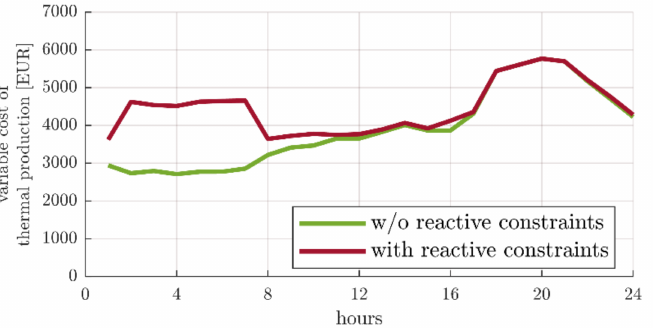
Figure 7. Hourly variable generation cost of the system in the lowest demand day, with reactive power constraints and in their